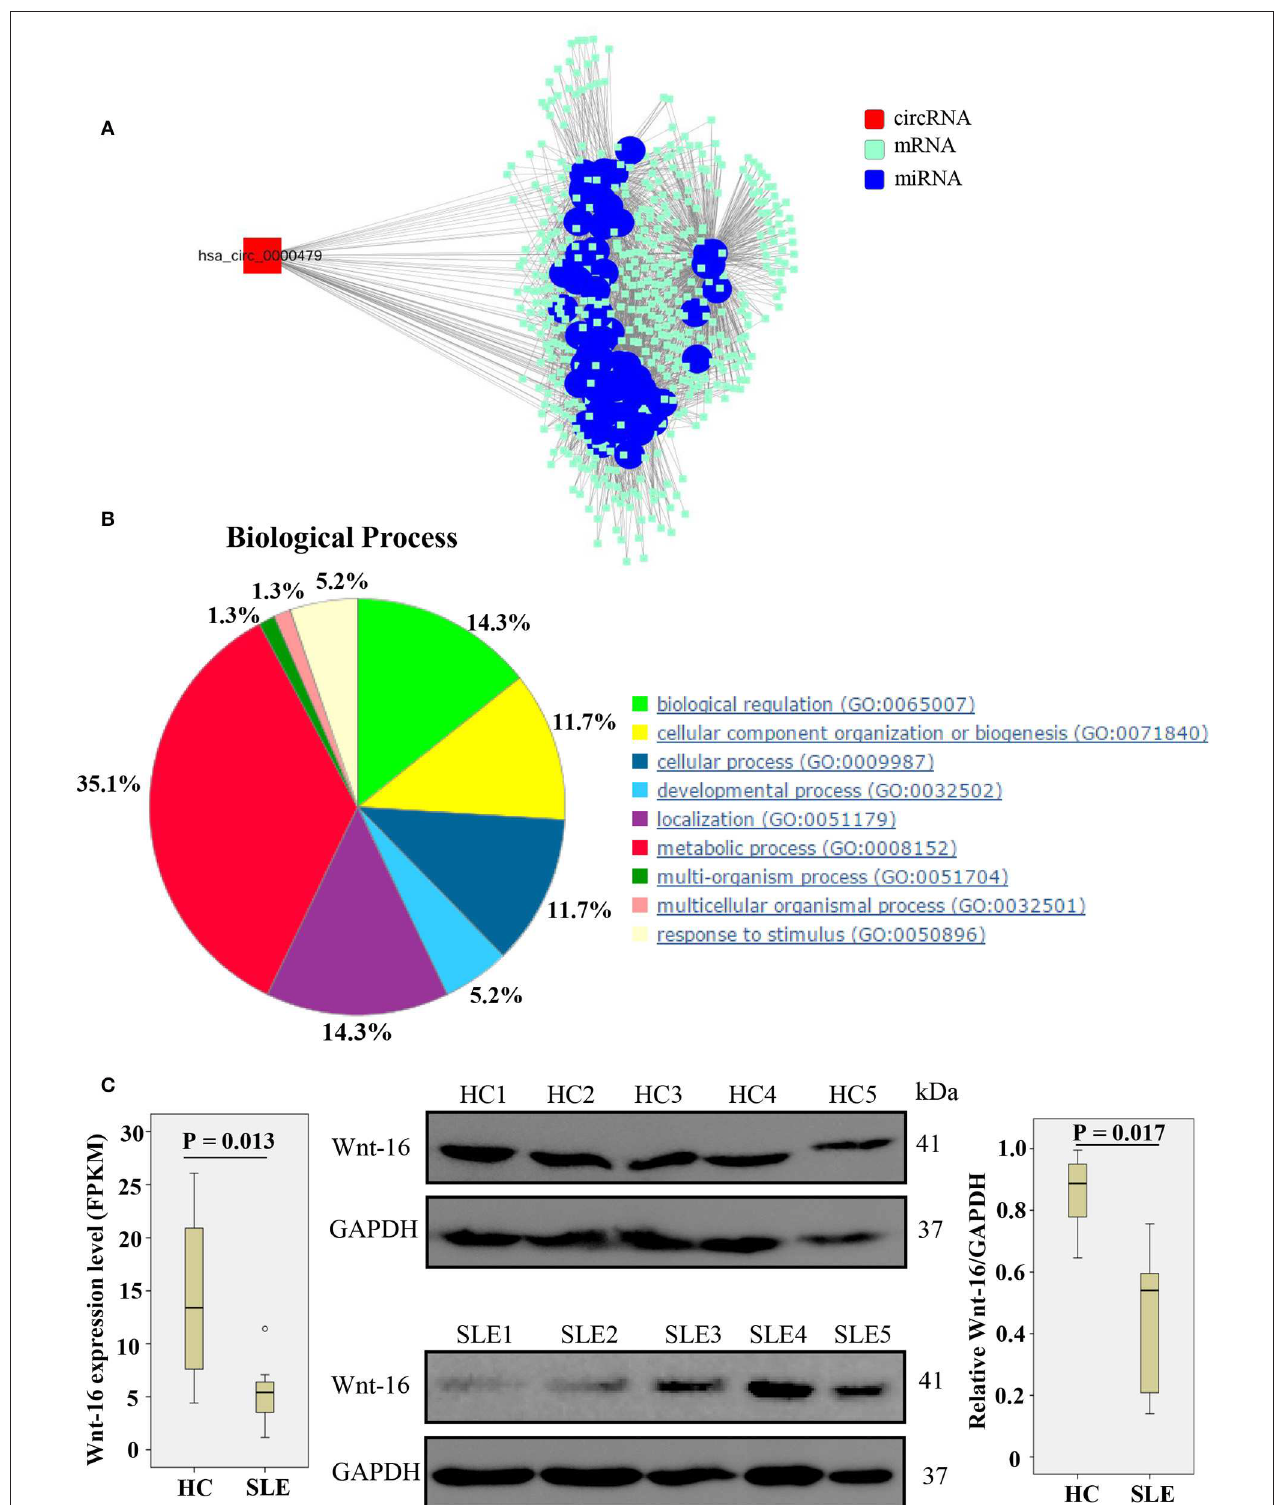
FIGURE 5 | Biological functions of hsa_circ_0000479 acting as a ceRNA. (A) Predicted circRNA-miRNA network. The SLE-related miRNA is annotated by blue nodes. (B) Biological processes associated with the target genes of hsa_circ_0000479. (C) Wnt-16 mRNA and protein expression in PBMCs from SLE patients and healthy controls. Wnt-16 mRNA expression was evaluated by NGS-Seq in the discovery phase. Wnt-16 protein expression levels were normalized to those of GAPDH.